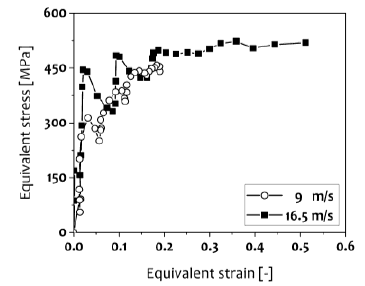
Fig. 6. Equivalent stress-strain curve obtained via high-speed bulge setup for two different impactor